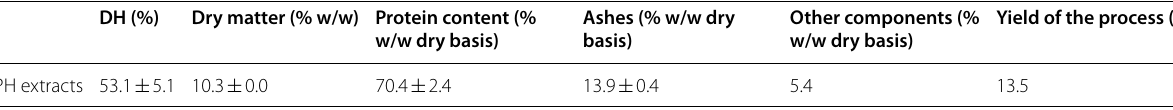
Table 1 Composition of the PH extracts DH (%) Ashes (% w/w dry